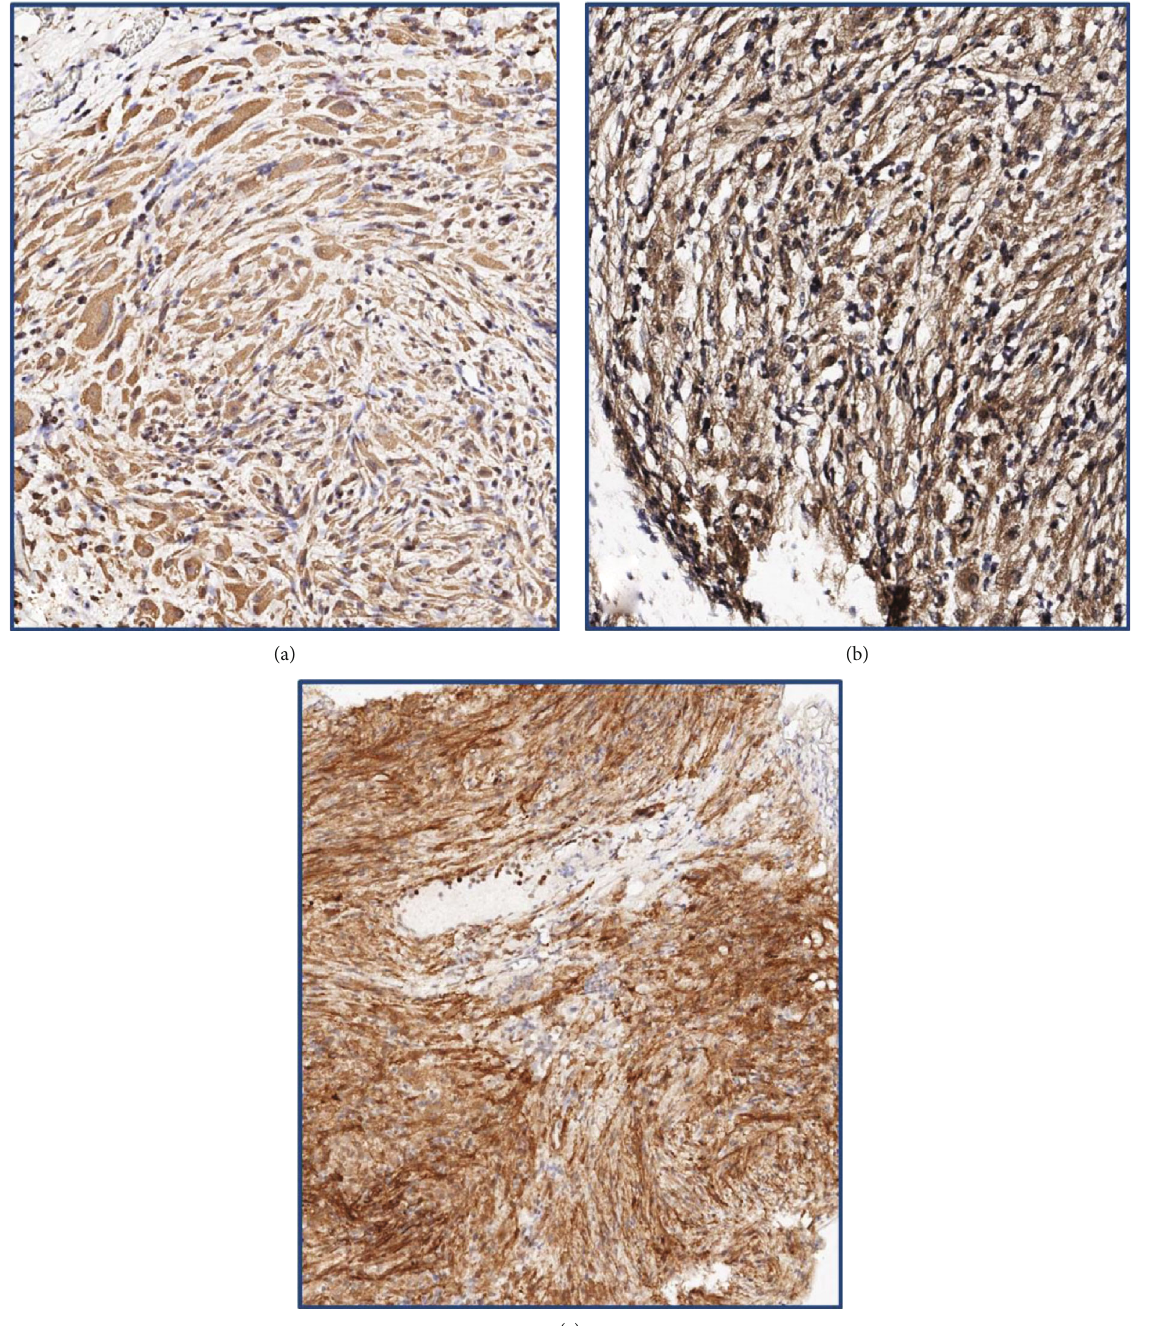
Figure 4: (a) The intensive di ff use cytoplasmic expression of vimentin in decidually transformed cells (magni fi cation × 400). (b) The di ff use cytoplasmic desmin expression in decidually transformed cells (magni fi cation × 400). (c) The intensive membrane and cytoplasm expression of CD10 in decidually transformed cells (magni fi cation × 400). CD10: cluster of di ff erentiation